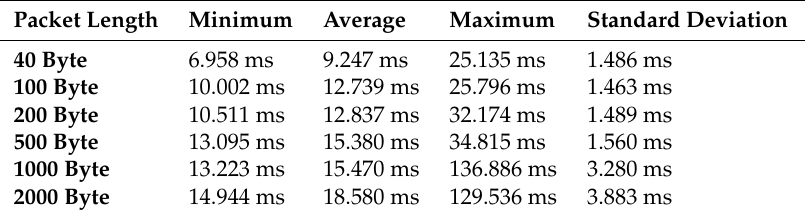
Figure 16. End-to-end 5G RTT results with different packet lengths—both the uplink and downlink uses 5G gNB; hence, one-way-delay is approximately half of the RTTs presented. Table 4. Public network statistics of the e2e 5G